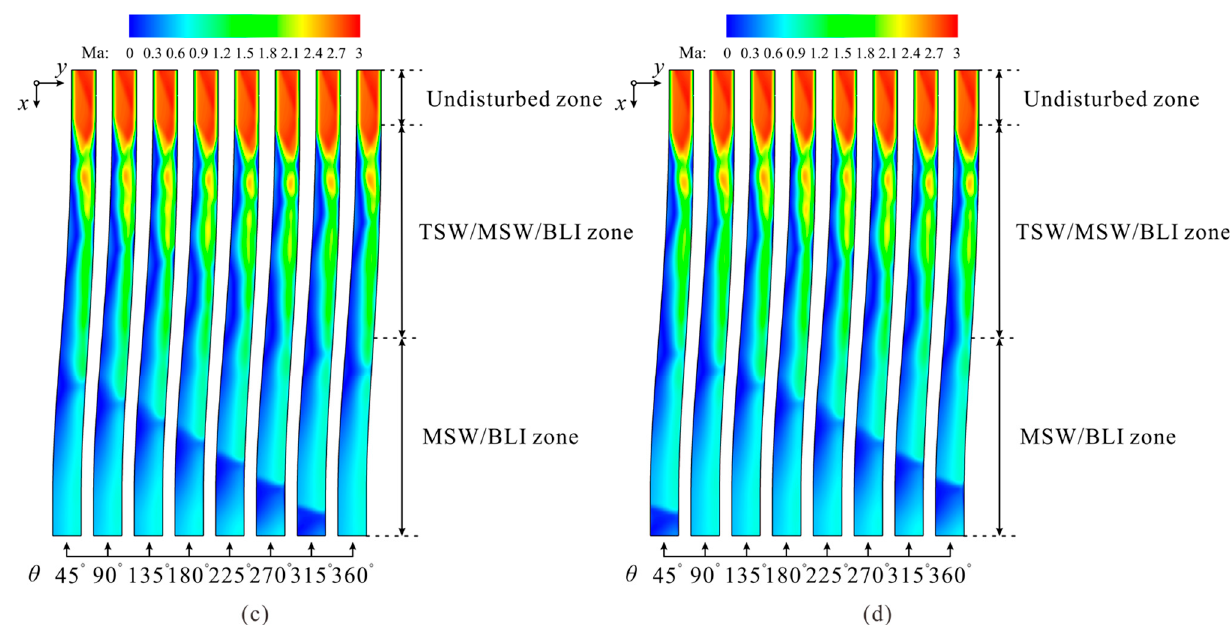
Figure 17. Mach number contours of eight meridian planes at different moments in one period. ( a ) t = n T . ( b ) t = (n + 1/4) T . ( c ) t = (n + 2/4) T . ( d ) t = (n + 3/4) T .